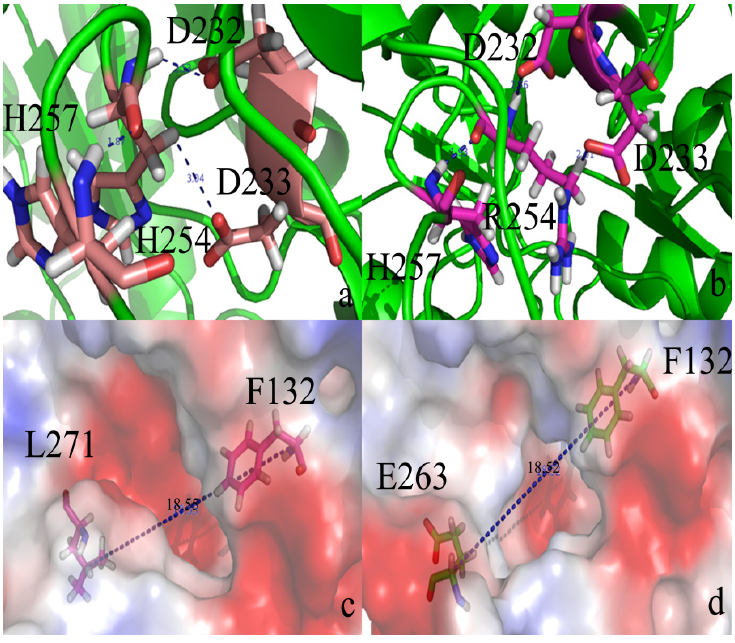
Figure 3. ( a ) H254 makes three hydrogen bonds with D232, D233, and H257, respectively in WT PTE; ( b ) R254 makes three hydrogen bonds with D232, D233, and H257, respectively in loop 7-2-H254R variant; ( c ) Leu271 and F132 function as the entrance gate in WT PTE; ( d ) Glu263 and F132 function as the entrance gate in loop 7-2-H254R